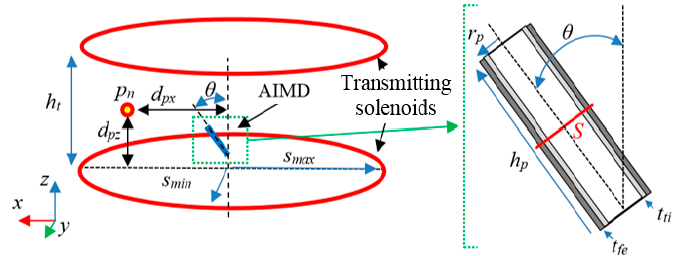
Figure 8. Sketch of a generic cylindrical active implantable medical device (AIMD) with a rotation θ between the excitation and the device coil axes.